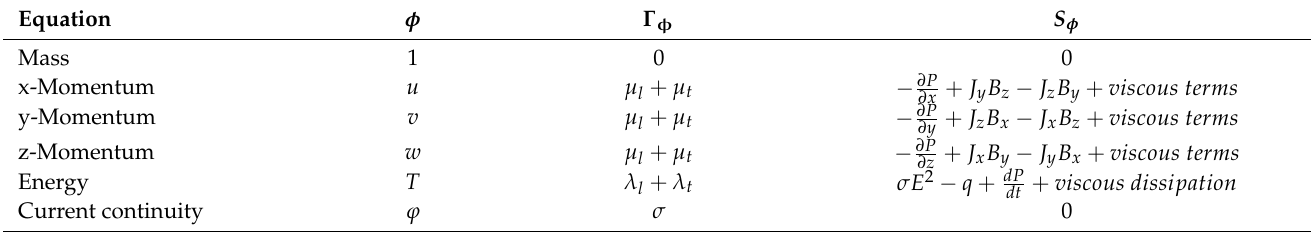
Table 1. Diffusion coefficients and source terms for the governing equations.